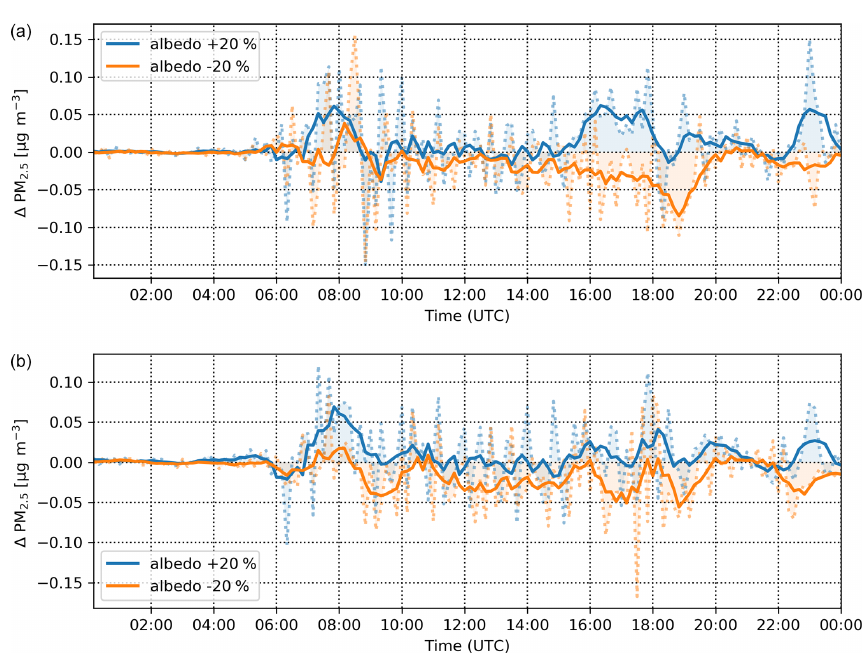
Figure 6. Changes in PM 2 . 5 for the north–south-oriented Komunard˚u street (a) and the west–east-oriented D ˇ elnická street (b) in scenarios SA01 (albedo + 20%, blue) and SA02 (albedo − 20%, orange). Dotted lines: 10min values; solid lines: 1h moving average.